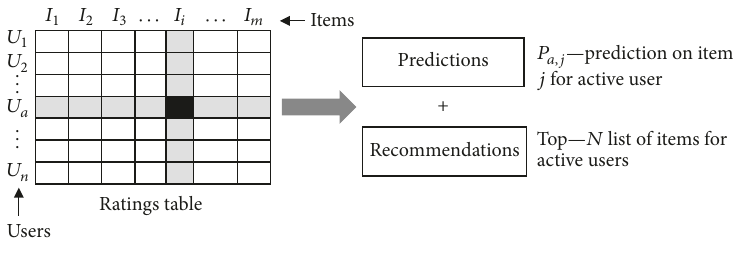
Figure 1: Collaborative filtering